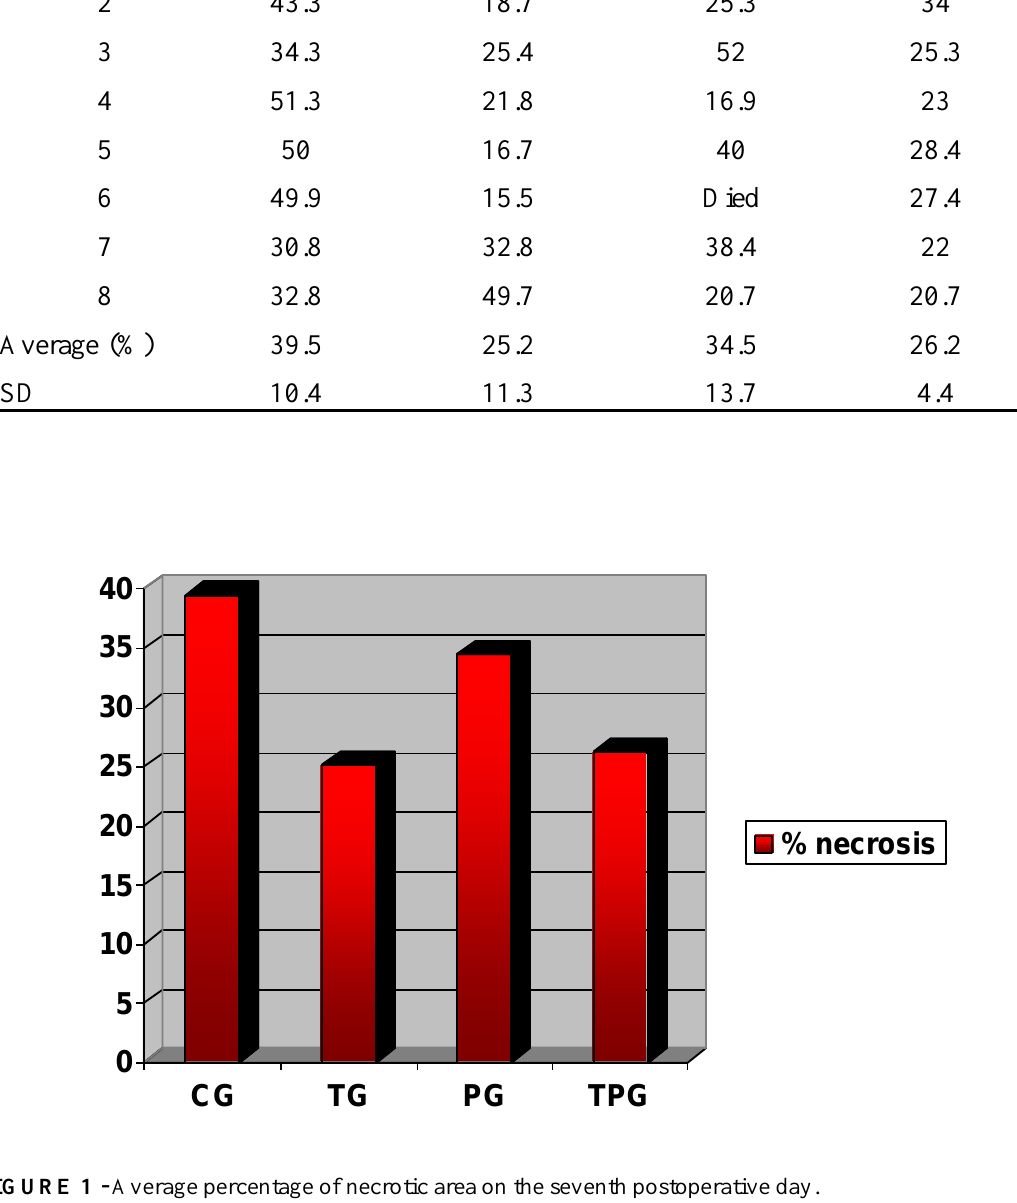
FIGURE 1 - Average percentage of necrotic area on the seventh postoperative day.